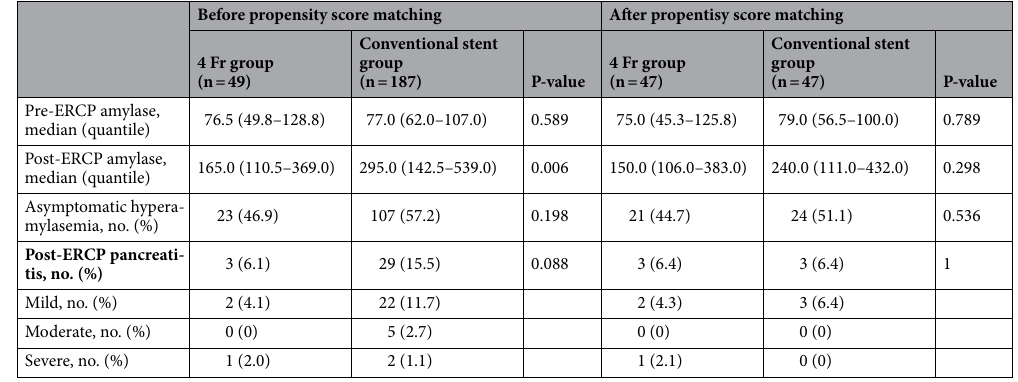
Table 4. Post-ERCP pancreatitis in each